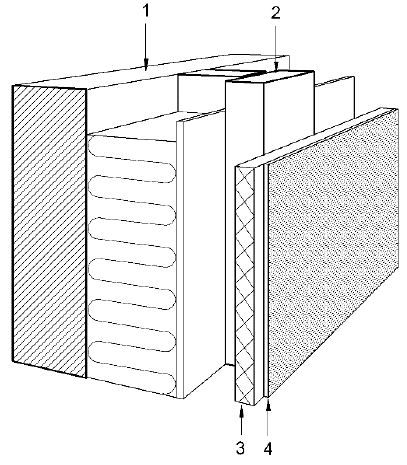
Figure 3. Render on ventilated cladding; (1) Underlying structure; (2) Battens; (3) Moisture-resistant wallboard; (4) Reinforced coarse render, primer, and final render [18].